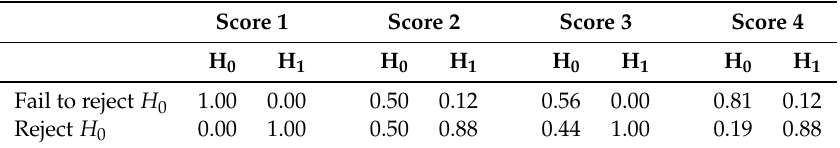
Table 8. Sensitivity and specificity of the test for each of the four scores when the size of the samples to diagnose is ν = 50 and the sensors used are numbers 1,2,4,5,6 and 7.